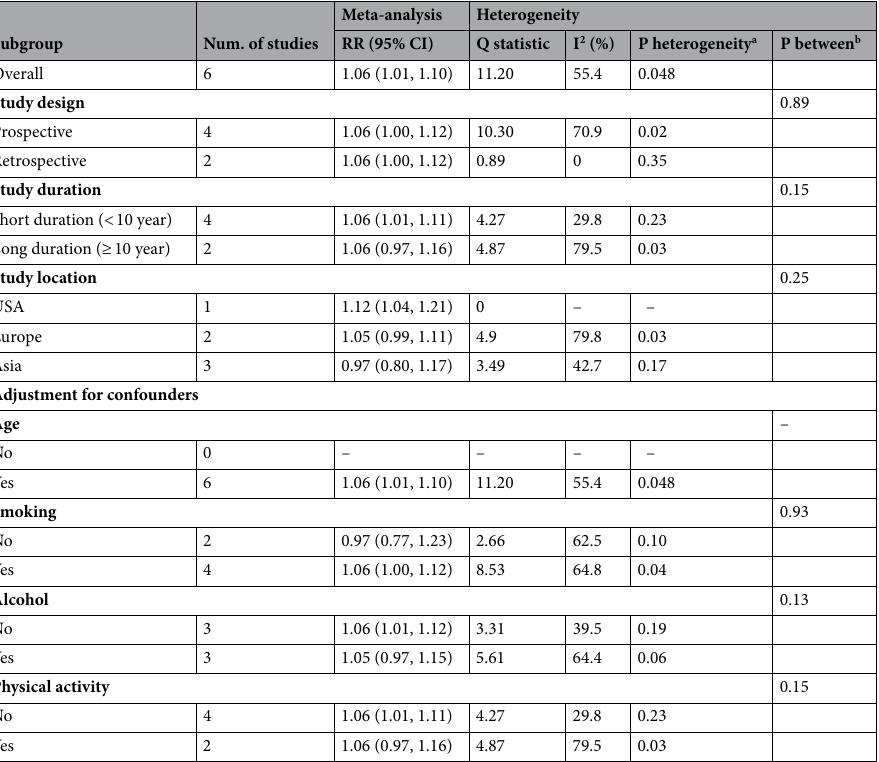
Table 1. Meta-analysis of body mass index and risk of total cancer in patients with T2D (all analyses were conducted using random-effects models). RR relative risk, CI confidence interval. a p-value for heterogeneity within groups. b p-value for heterogeneity between